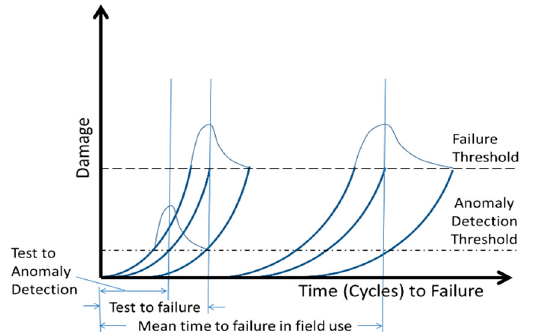
Figure 3. Time-to-failure in the field can be predicted from testing. Accelerated testing shortens the time-to-failure by increasing stress levels. Prognostic accelerated testing additionally shortens the test time by reducing the damage level at which the prediction of failure (PoF) is made from the failure threshold to the anomaly detection threshold. PoF models are used to relate the anomaly detection threshold to the failure threshold and to relate the time-to-failure in the test to the time-to-failure in the field.